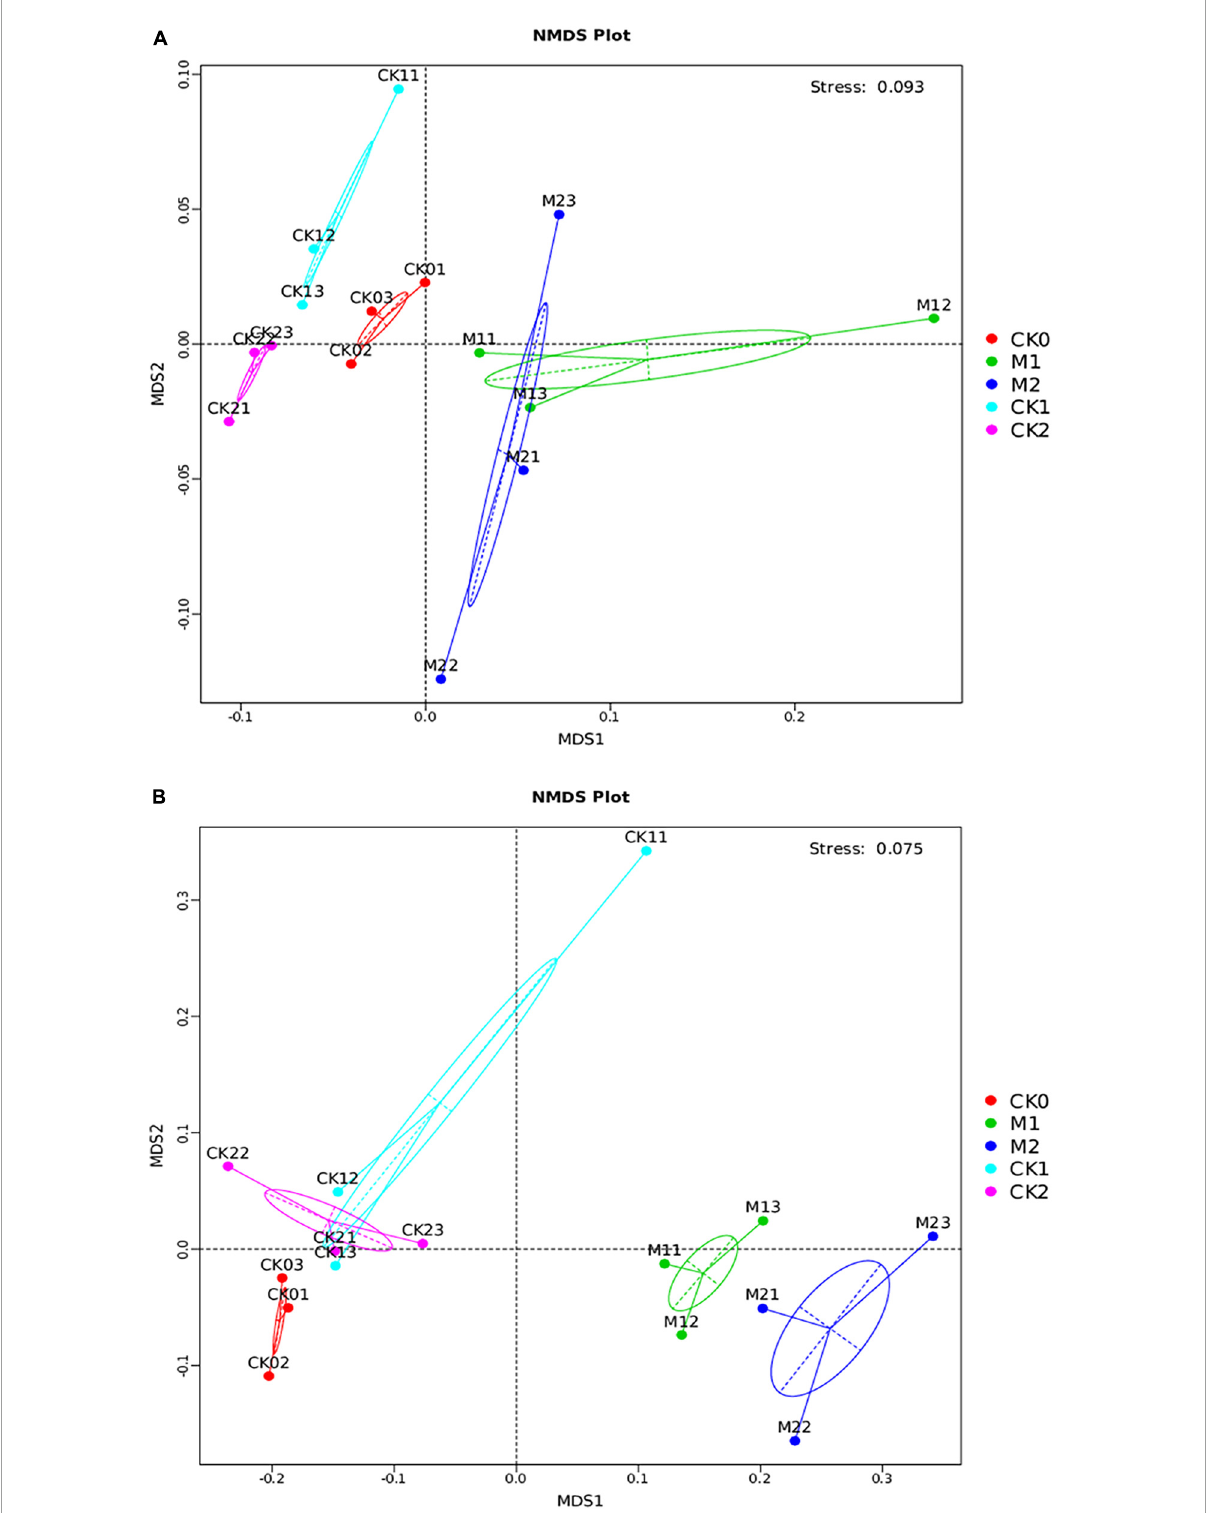
FIGURE4 Differences in microbial community structure among the five sample types. Bray curtis NMDS analysis of bacterial community (A) and fungal community (B) at the OTU level. The top right corner of (A,B) shows the stress value of the NMDS analysis.